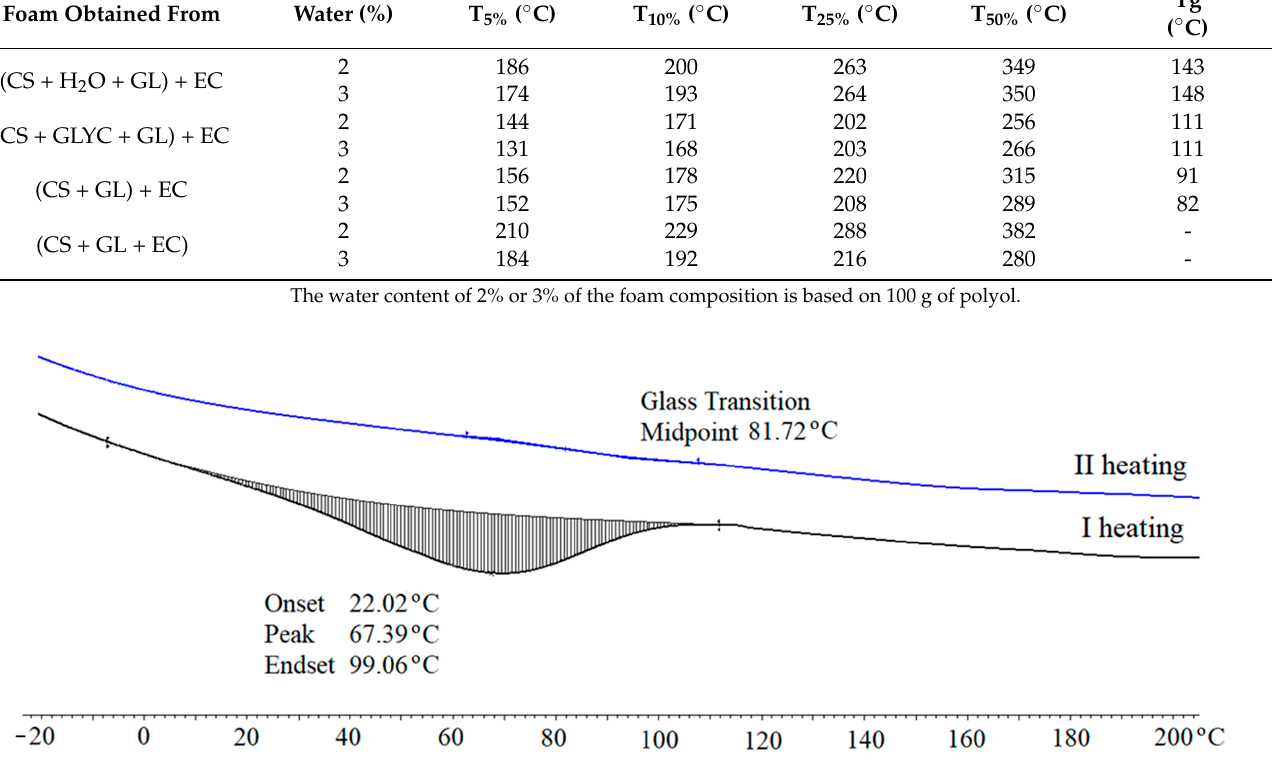
Figure 13. DSC thermogram of foam obtained from polyol (CS + GL) + EC (3% H 2 O/100 g of polyol).